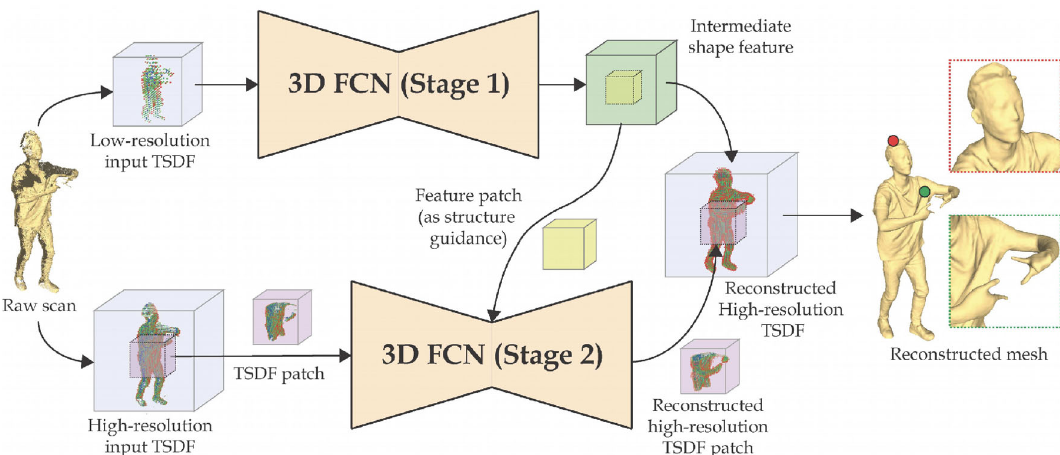
Fig. 5 Two-stage 3D-CFCN architecture for 3D body reconstruction from low quality raw depth scans. An intermediate representation is produced with a fused low-resolution TSDF volume for stage 1 of the 3D-FCN. Then the network regresses a complete low-resolution TSDF and predicts TSDF patches for further refinement. Next, for each patch to be refined, the corresponding block is taken from a fused high-resolution input TSDF to infer a detailed high-resolution local TSDF volume that can substitute for the corresponding block in the regressed TSDF for quality improvement. Reproduced with permission from Ref. [78], c (cid:2) Springer Nature Switzerland AG 2018.